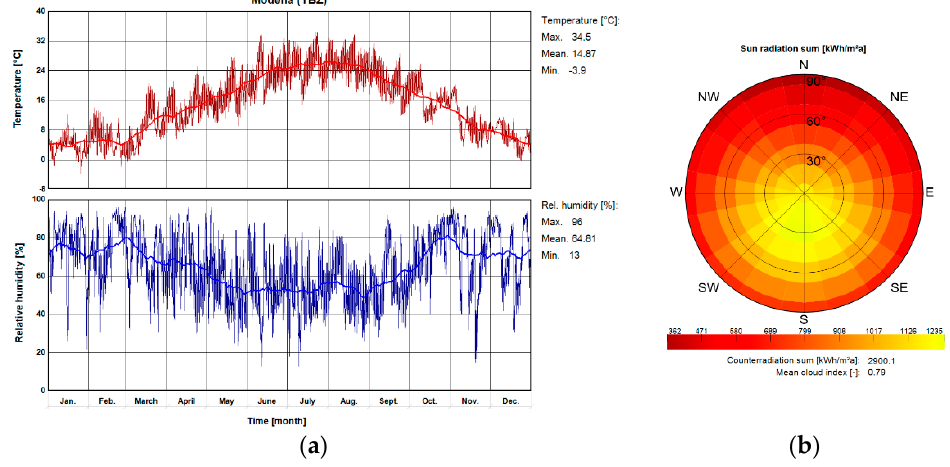
Figure 8. TRY characteristics for Modena: ( a )—air temperature and relative humidity; ( b )—solar radiation intensity. Source: WUFIplus ® database.